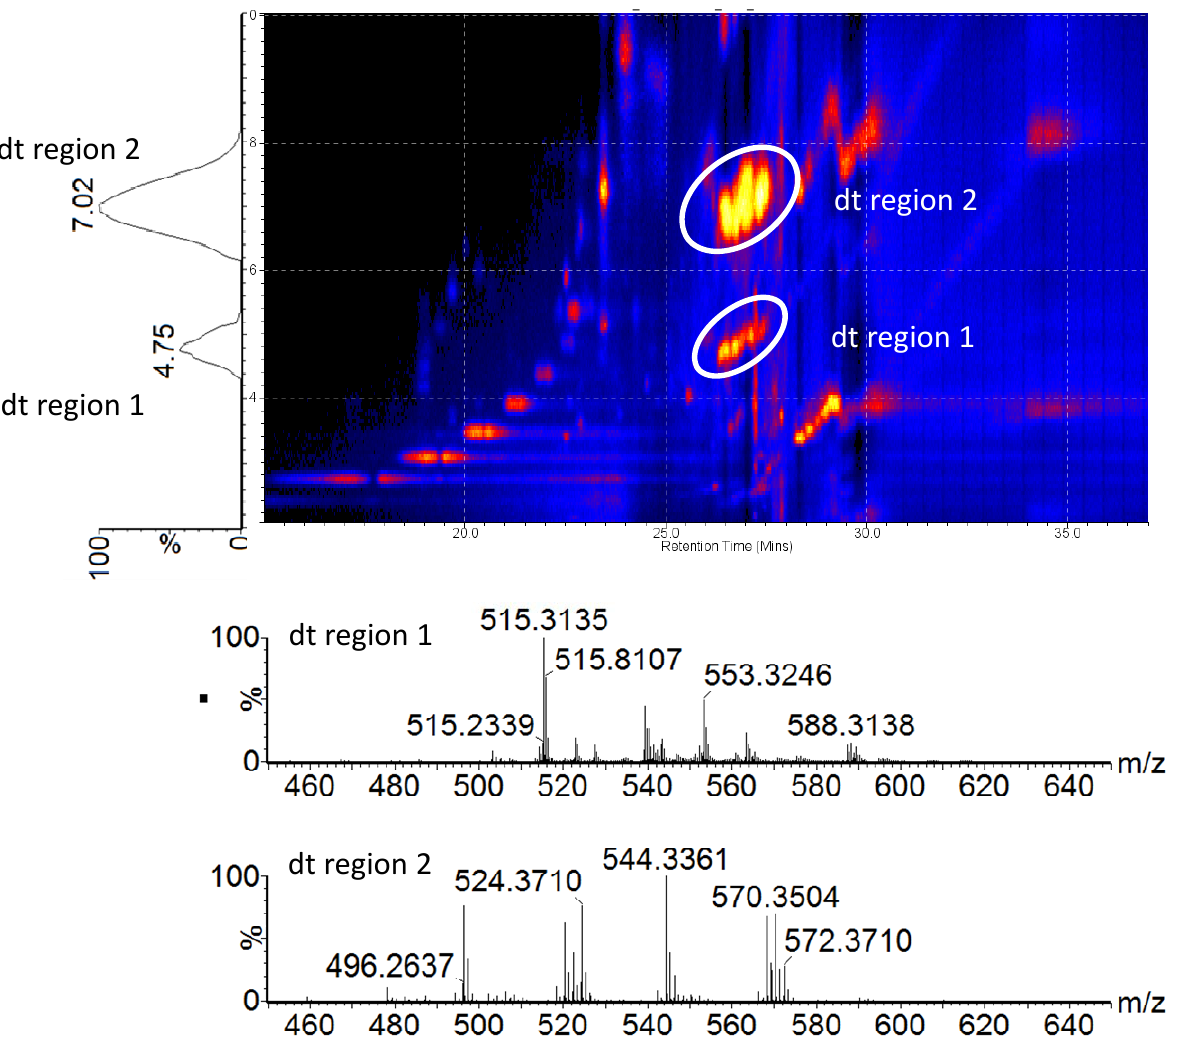
Figure 3. An example of a 2D image (drift time vs. retention time) showing the ion mobility separation of different compound classes in rat plasma samples. The encircled regions mark the compound classes that eluted within a similar retention time window (26–28 min). Drift time-extracted spectra (bottom) show that these two clusters belong to different lipid classes, namely Lyso-PC and SM lipids (sphingosine phosphocholines) that have drift time distributions centered around 7.02 ms and 4.75 ms,